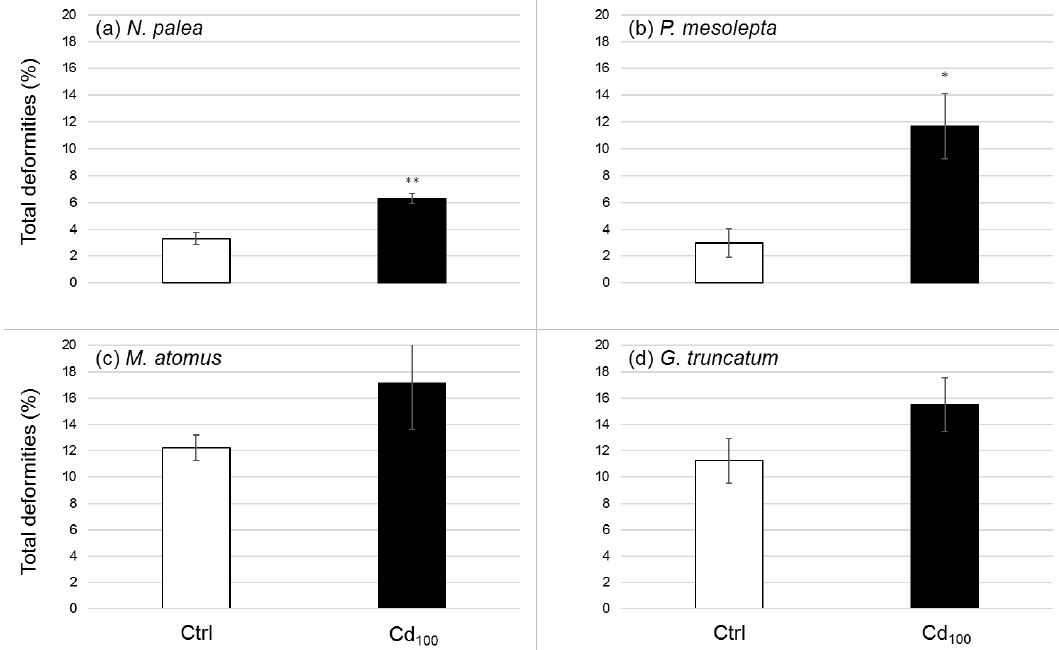
Figure 7. Mean e ff ective percentage of total deformities ( ± standard error) in ( a ) N. palea , ( b ) P. mesolepta , ( c ) M. atomus , and ( d ) G. truncatum cultures after 21 days of the experiment for the control (Ctrl) and the Cd treatment (Cd 100 ). The deformities a ff ecting the shape of G. truncatum were not considered in the calculation of the percentage of total deformities. Stars indicate statistical di ff erences from the control ( n = 3, * p < 0.05, ** p < 0.01).